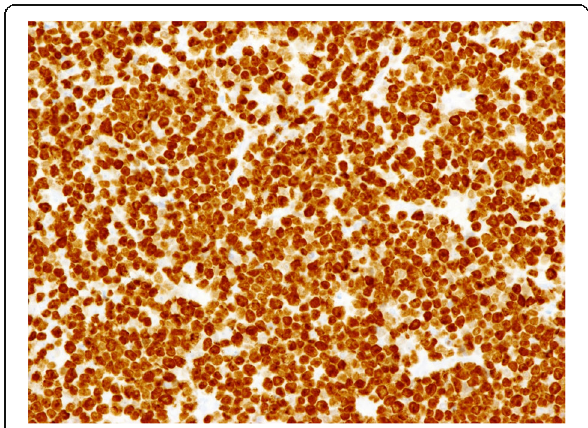
Fig. 3 Immunohistochemical staining of thyroid Burkitt ’ s lymphoma. Almost all of the tumor cells are immunoreactive against Ki-67 (×